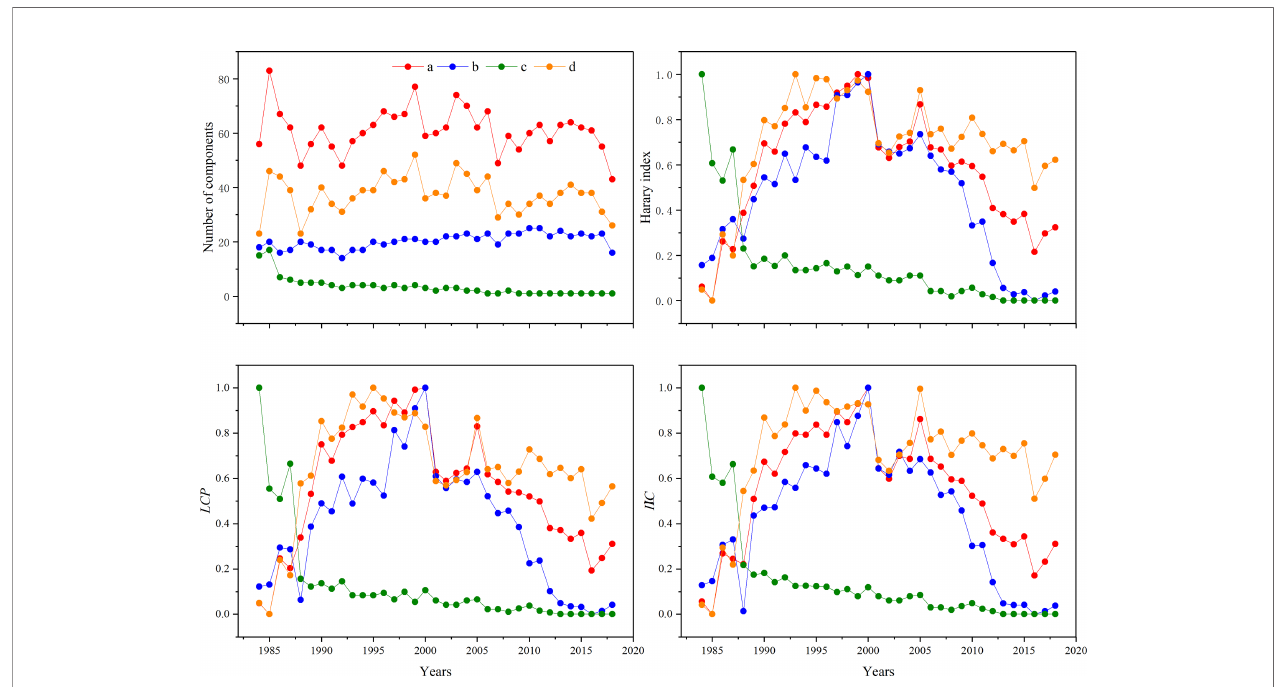
FIGURE 4 | Connectivity indices dynamics in the YRD (a represent the whole scale, b, c and d represent erosion zone, oil fi eld zone and deposition zone respectively).